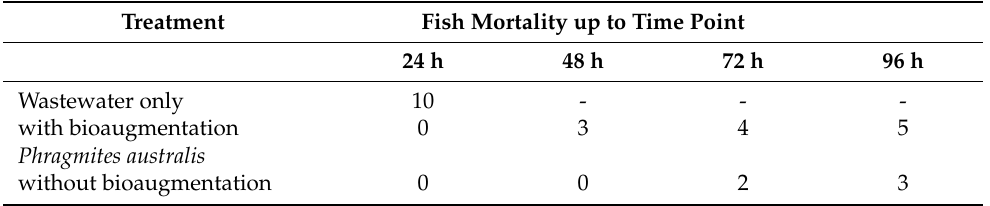
Table 5. Fish toxicity assay with initially 10 individuals of Labeo rohita in oil-contaminated